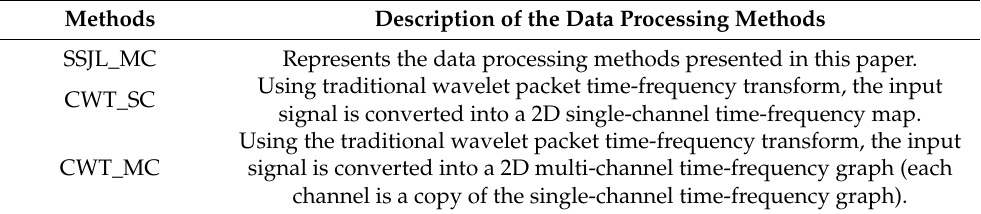
Table 3. Description of different data processing methods.